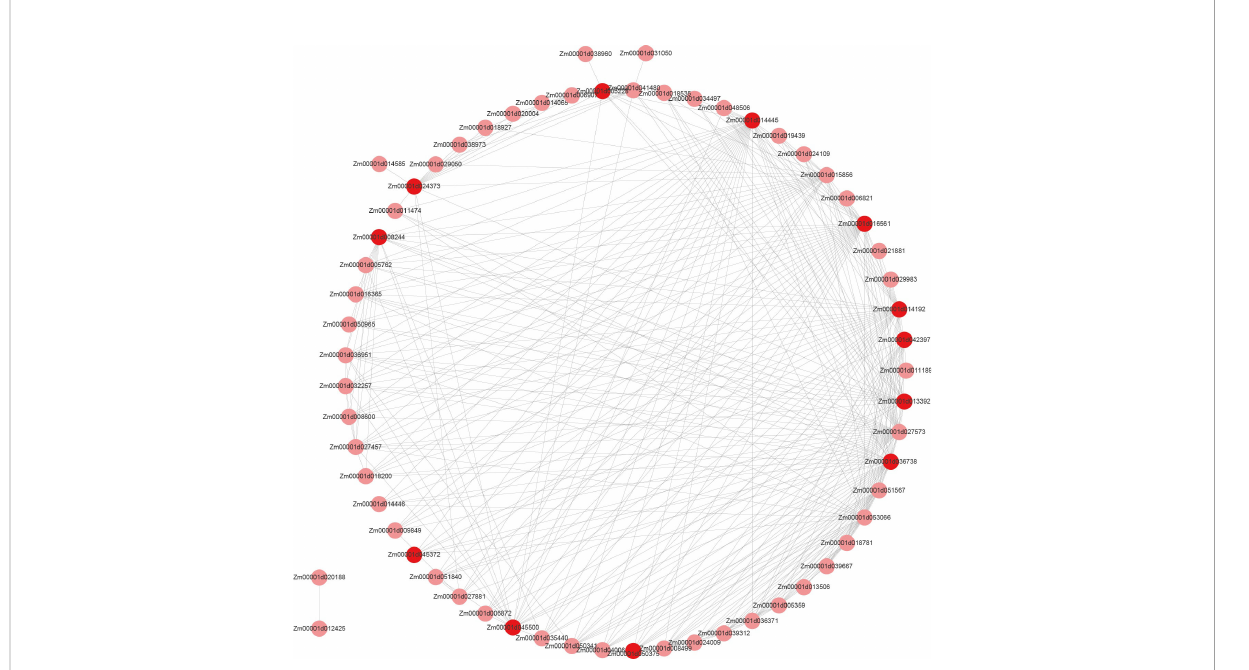
FIGURE 9 Co-expression regulatory network analysis of the white module. Red represents hub genes.